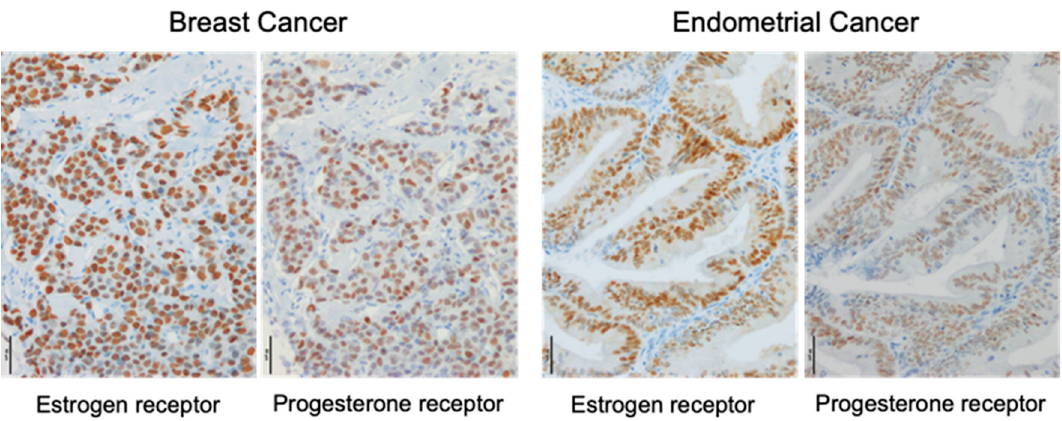
Figure 1. Immunohistochemistry of estrogen and progesterone receptors in breast and endometrial cancers. Immunoreactivities of the estrogen receptor α and progesterone receptor were detected in the nucleus (brown) of carcinoma cells. Scale bar, 50 μ m.